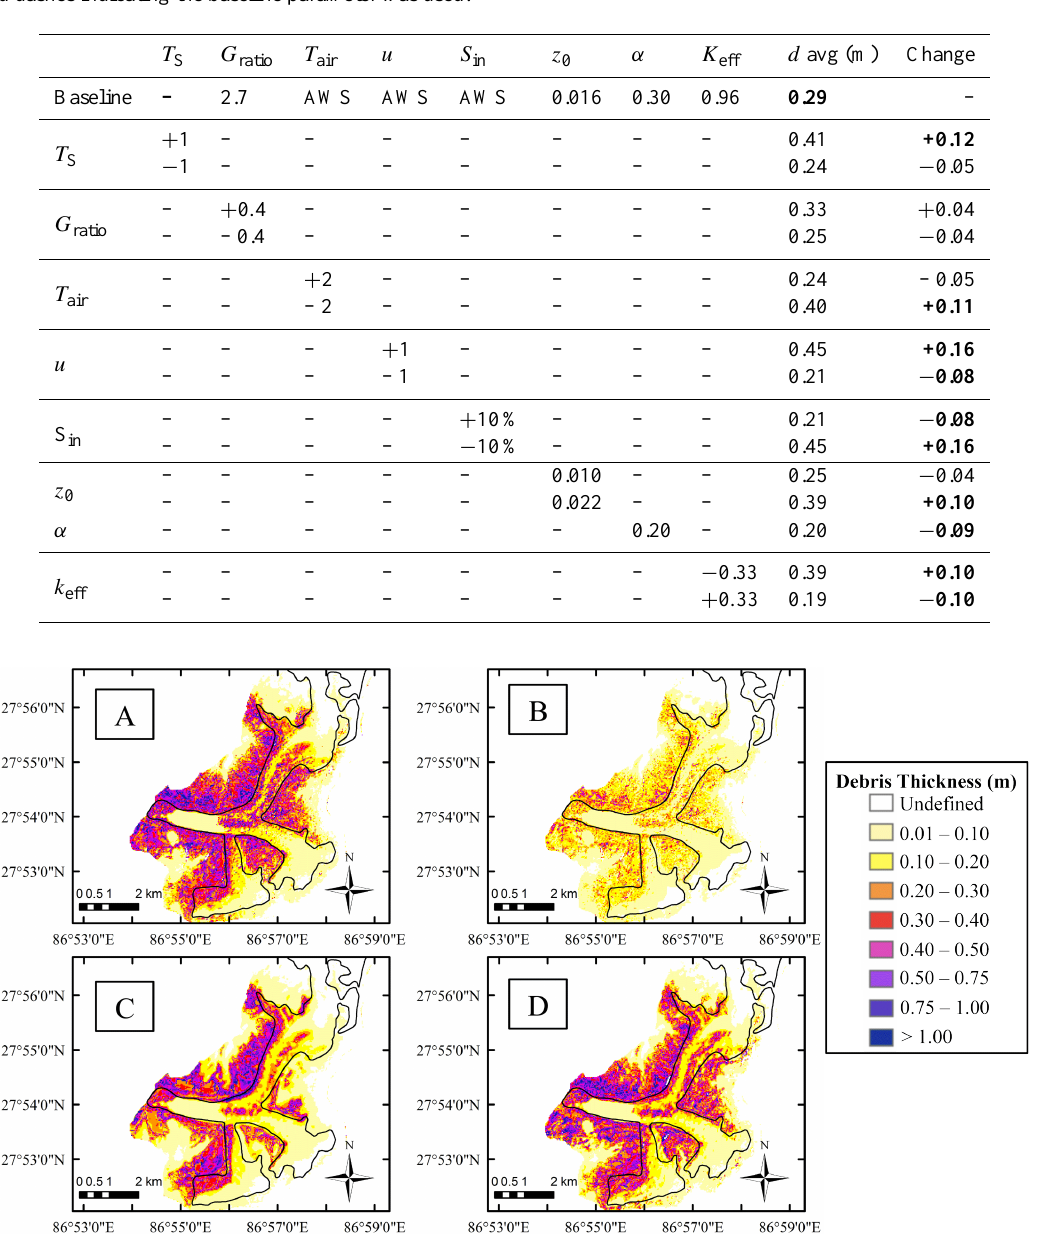
Figure 6. Debris thickness (m) with 30m pixels using the (A) nonlinear sloped model, (B) linear sloped model, (C) nonlinear flat model, and (D) using the ASTER GDEM with the nonlinear sloped